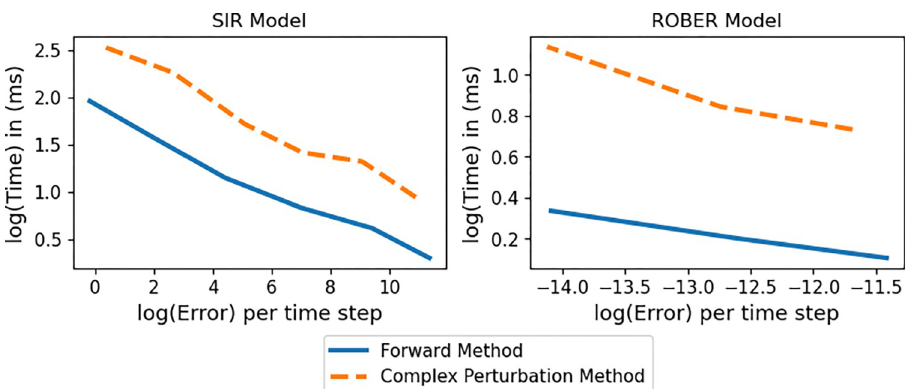
Fig 7. Time vs Error of Forward and Complex Perturbation Methods for Numerical Sensitivities. Time versus error log-log plot of the SIR model (left) and ROBER model (right) simulated over t = 1000 days. For SIR the initial conditions are S 0 = 3.4 × 10 8 , and I 0 = 100, and the parameters are η = 0.7194 and δ = 0.5025. For ROBER the initial conditions are x 1 = 1.0, x 2 = 0.0, and x 3 = 0.0, and the parameters are p 1 = 4 × 10 − 2 , p 2 = 3 × 10 7 , and p 3 = 1 × 10 4 . First- order sensitivities are computed via code from this manuscript (complex perturbation method) and the ForwardDiff.jl package (forward method). Times reported are the median times computed using the Benchmark.jl package, and errors are the Euclidean distance between the solution at the strictest tolerance (10 − 8 for SIR and 10 − 5 for ROBER) and the solution at a variety of tolerances with a maximum of 10 − 2 . All errors are normalized by the number of time steps.